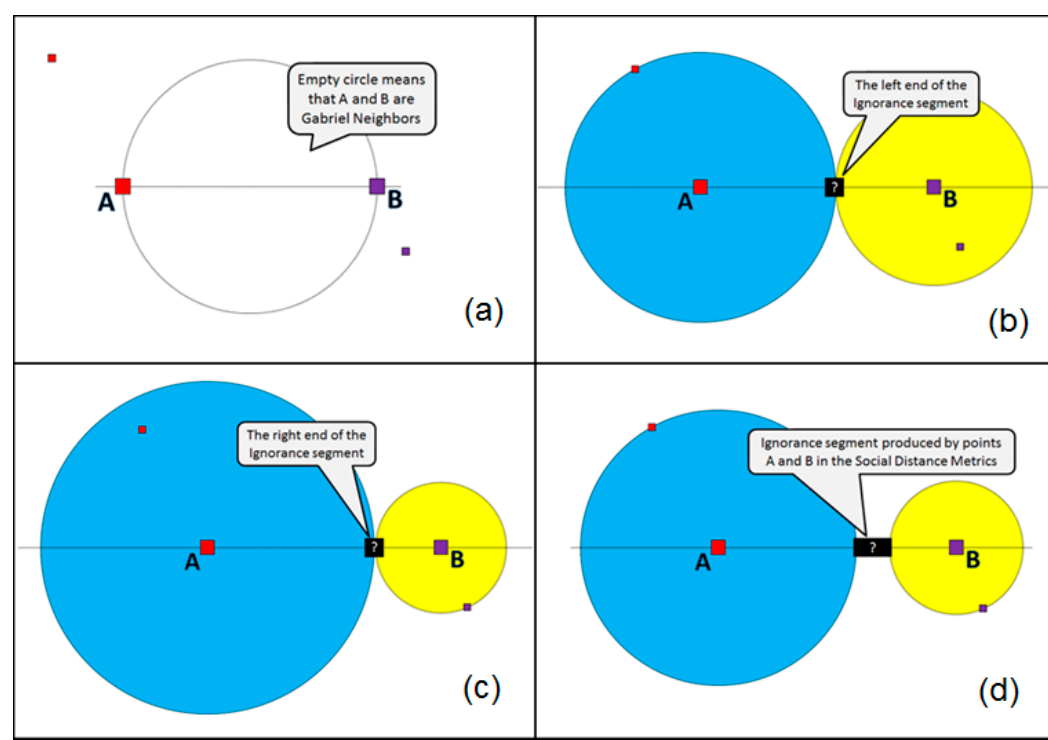
Figure 8. Illustration of the ignorance computed with the Social Distance Metric: ( a ) selection of a pair of points A and B, which are the Gabriel Neighbors; ( b ) computing the left end of the ignorance segment as a touch-point of the two circles (the left circle touches also the nearest same-color neighbor of point A); ( c ) computing the right end of the ignorance segment as a touch-point of the two circles (the right circle touches also the nearest same-color neighbor of point B); ( d ) resulting ignorance line-segment visualized. One may notice that the ignorance focus produced by two points A and B in the Social Distance Metric is not just a unique middle point between A and B but it is a line segment. The requirement for the ignorance line segment between A and B is that that amount of homogeneous data points within the blue circle around A is the same as the amount of data points within the yellow circle around B.